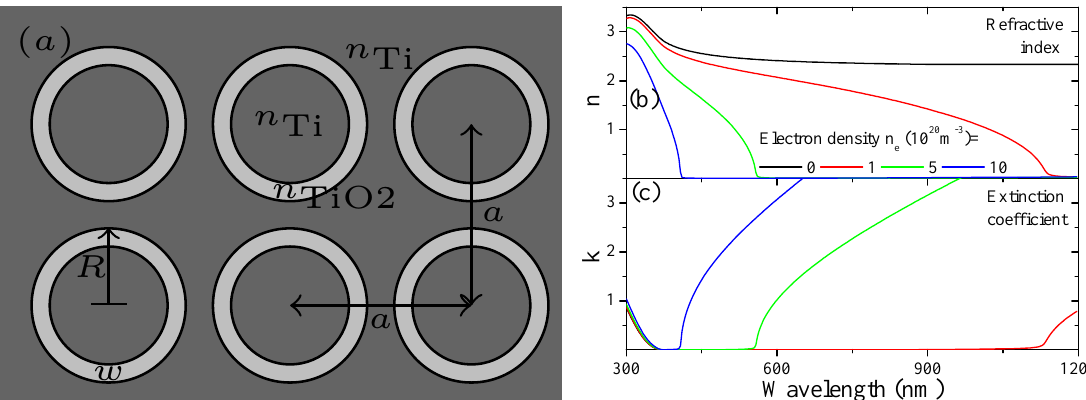
Figure 2. ( a ) Top view of the simulated, two-dimensional structure depicting the lattice period a , outer radius R and wall thickness w ; ( b ) Refractive index n and ( c ) extinction coefficient k of TiO 2 for different levels of electron doping and the original data.